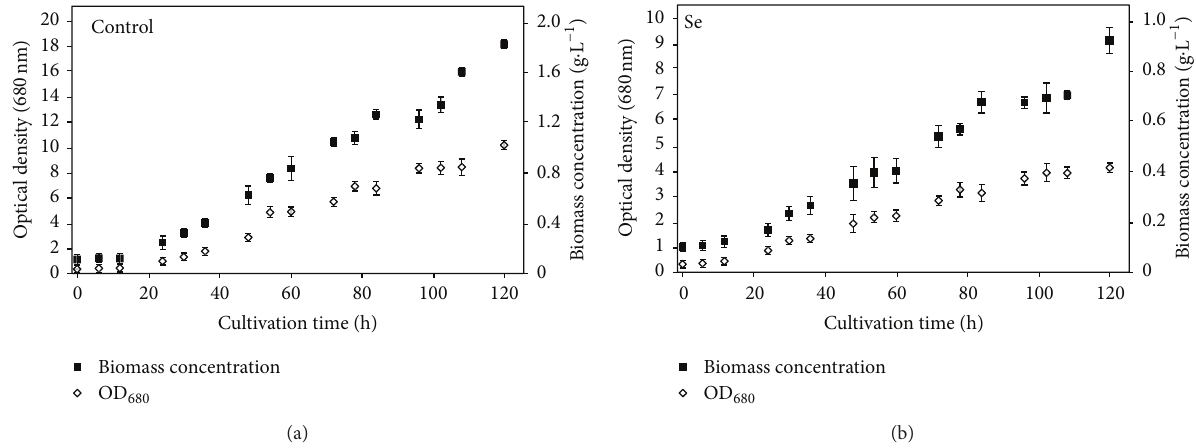
Figure 2: The optical density and biomass concentration of Chlorella sorokiniana as a function of cultivation time for (a) control (no selenate) and (b) culture with 40 mg ⋅ L −1 of selenate in culture medium. Data are given as mean values ± S.D. of the means. Table 2: Values of EC parameter for microalga cultures exposed to Se salts, expressed as Se(+IV) and/or Se(+VI) concentrations 50 (mg ⋅ L − 1 / 𝜇 mol ⋅ L − 1 ) in culture medium, as determined and published in the literature. In some studies Se concentrations (in mg ⋅ L − 1 ) were expressed based on weight of elemental Se, while in present study it was expressed based on weight of sodium selenate (Na adapted from V´ıtov´a et al. (2011)